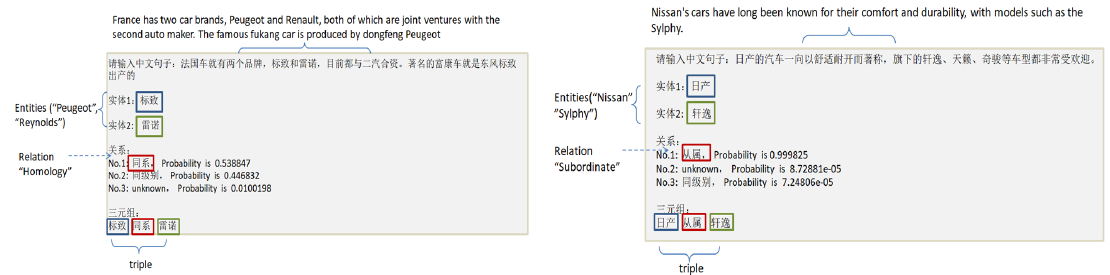
Figure 18. Some examples of triple